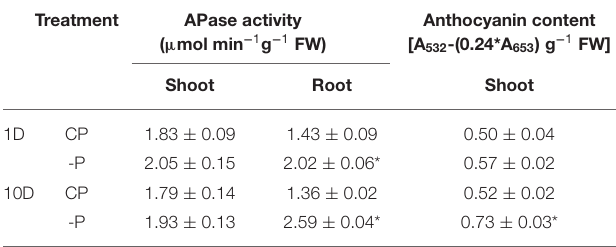
TABLE 6 | Effects of Pi deficiencies on APase activity and anthocyanin content in Zygophyllum xanthoxylum .